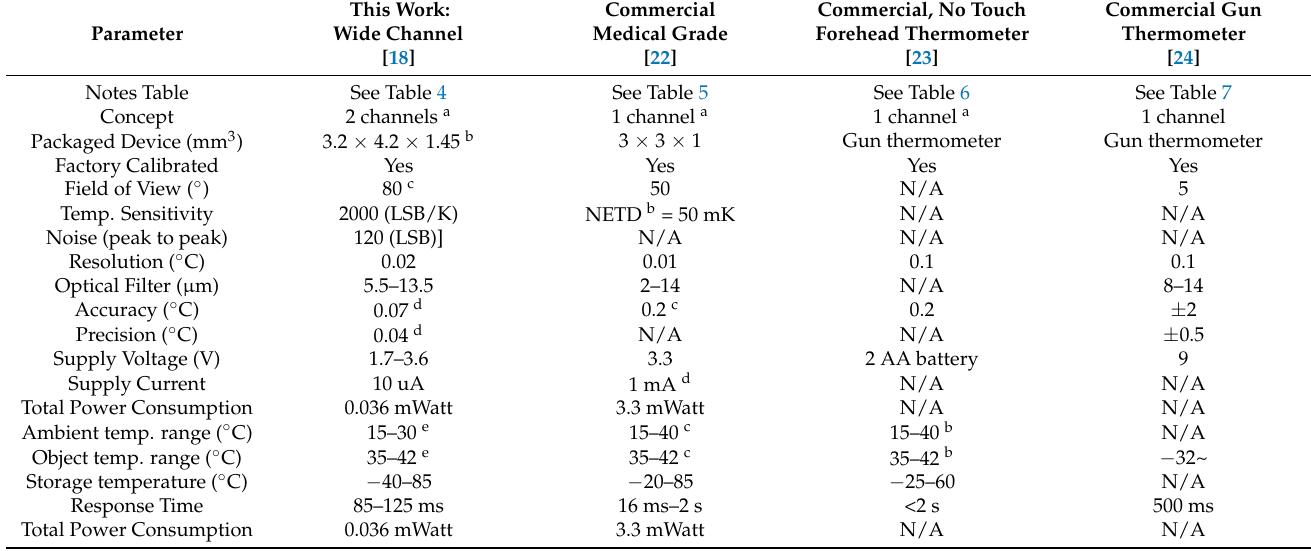
Table 3. Performance comparison of the radiometer understudy and commercial products that are considered state-of-the-art. The superscripts in the table are elaborated in the tables below for each product (referred to as the Notes table). The “channel” refers to the optical